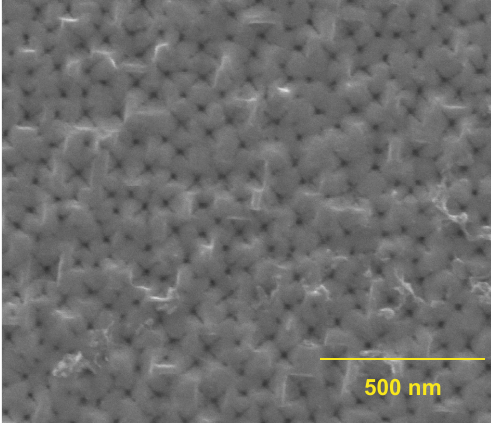
Figure 2. Cross-section SEM image of the sacrificial double layer (SDL) formed by the ENL process, before its dissolution. The first (SDL-1) and second (SDL-2) layers are identified by the description on the right side of the image.